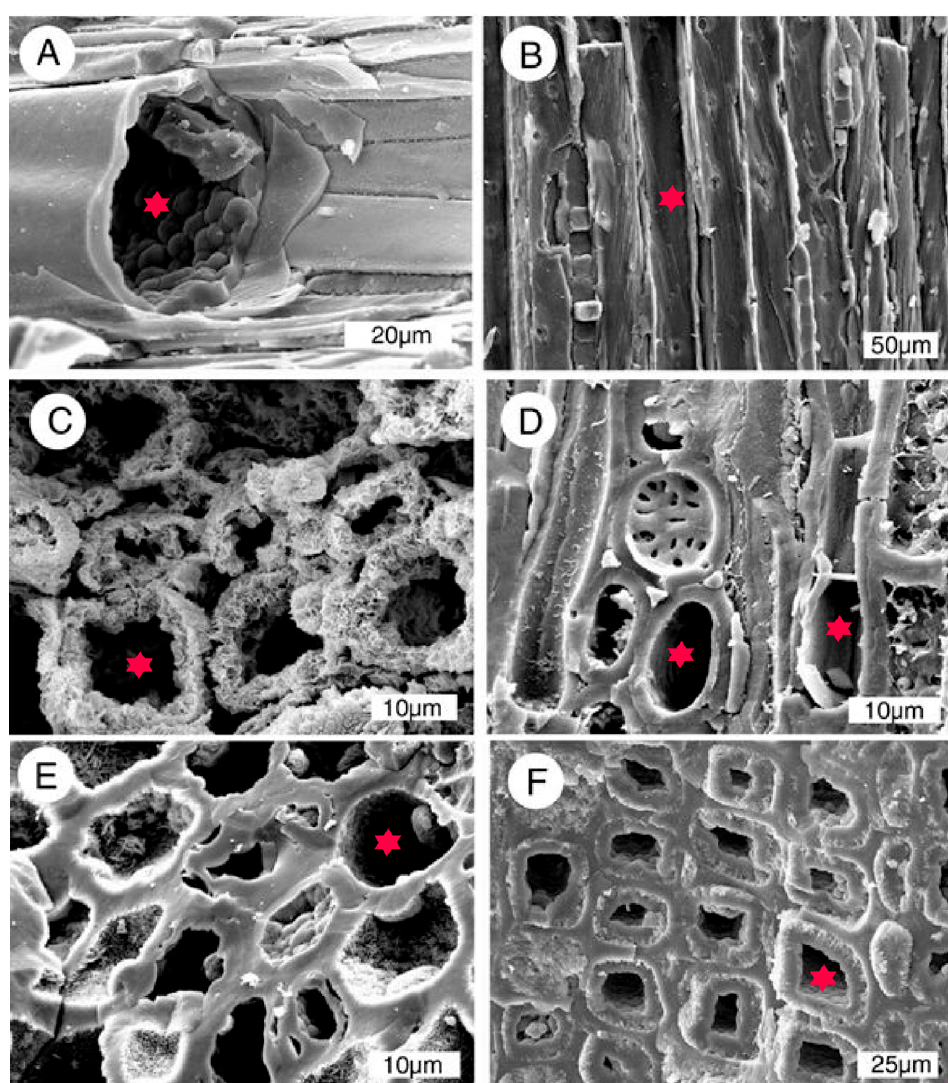
Figure 2. Scanning electron microscopy (SEM) images of silicified woods with mineralized cell walls and empty lumina (some examples are marked with star symbols). ( A ) Miocene conifer wood showing a tracheid with opaline walls and botryoidal opal-A layer on interior surface, Lyon County, NV, USA; ( B ) Miocene opalized wood from Lovelock, NV, USA, Radial orientation showing silicified cell walls and empty lumina; ( C ) Miocene wood from Norita Opal Mine, Virgin Valley, NV, USA. Transverse view shows cell walls containing an interior lining of microcrystalline opal-CT; ( D ) Tertiary opalized wood from Soccorro, NM, USA. Radial view showing detailed anatomical preservation; ( E ) Transverse orientation, Miocene wood from Cessily Anne Opal Mine, Virgin Valley, NV, USA. Opal replacement of cell walls obliterated the original multi-layered architecture. Lumina are lined with botryoidal opal-A and microcrystalline opal-CT; ( F ) Miocene wood from Washoe County, NV, USA, transverse orientation. Cell walls are replaced by opal-A, with botryoidal textures on interior surfaces.